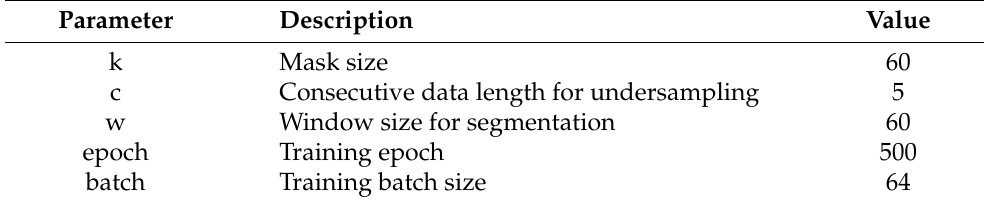
Table 4. Parameter list and value in experiments.